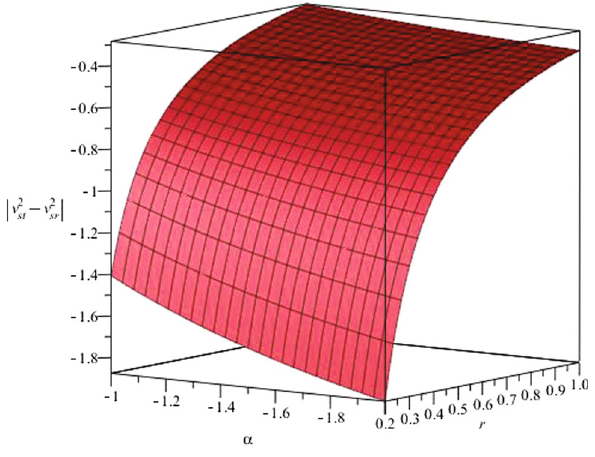
Fig. 6 Plots of | ν 2 st − ν 2 sr | against r and α using M 0 = 1 M (cid:9) and R = ( 0 . 3 ) − 1 M (cid:9) for